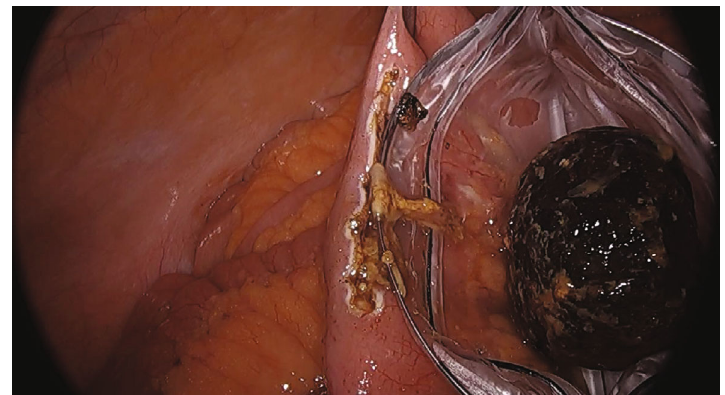
Figure 3: Gallstone placed in endoscopic retrieval bag.